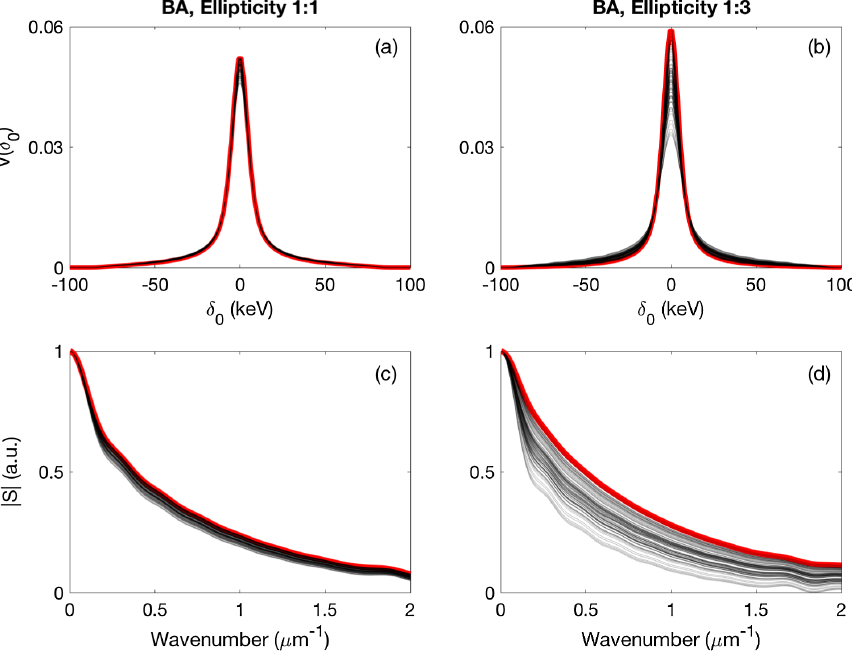
FIG. 7. Energy redistributions and suppression factor plots for BA. Energy spreads are optimized for rms energy spread.